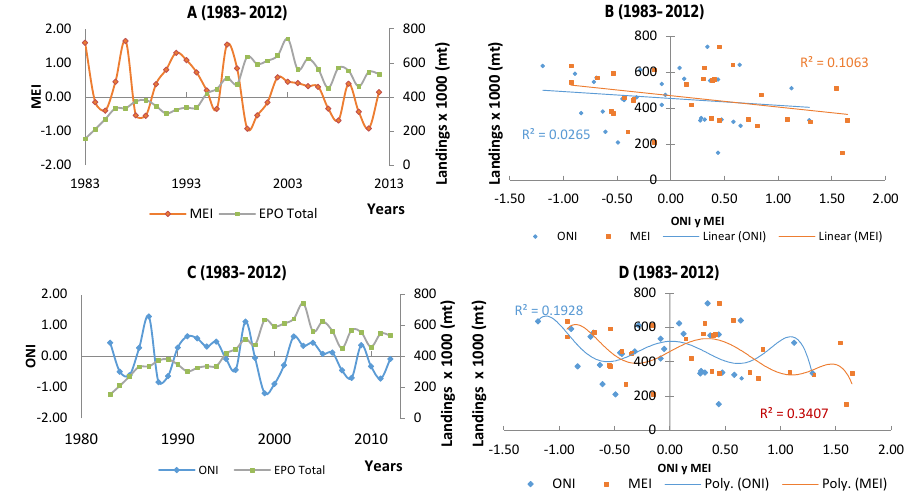
Figure 2. Total tuna landings (mt) in the EPO (1983–2012), MEI (a) , and ONI (c) indexes yearly averaged in time, and linear correlation MEI (b) and ONI (d) and landings. Data NOAA and IATTC